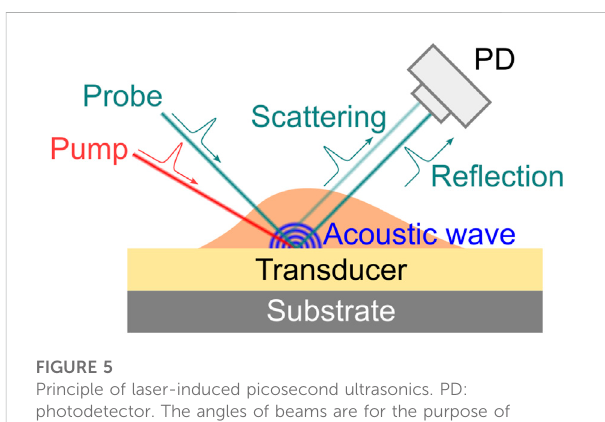
FIGURE 5 Principle of laser-induced picosecond ultrasonics. PD: photodetector. The angles of beams are for the purpose of demonstration only. Normal illumination/detection is usually used in